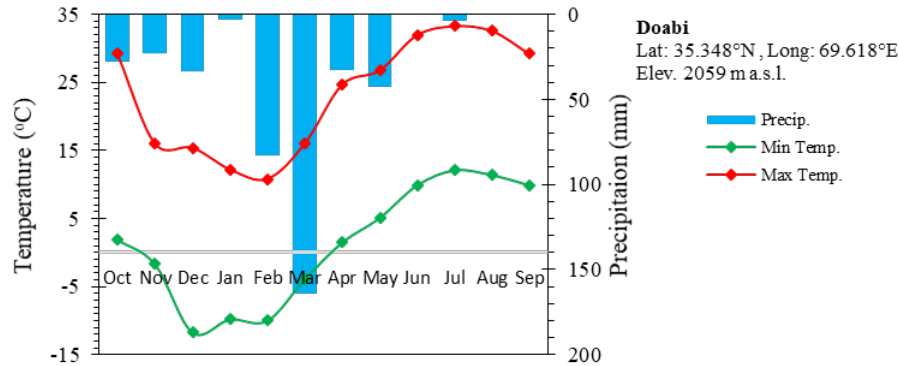
Figure 3. Hydro-climatic data in the Panjshir sub-basin.